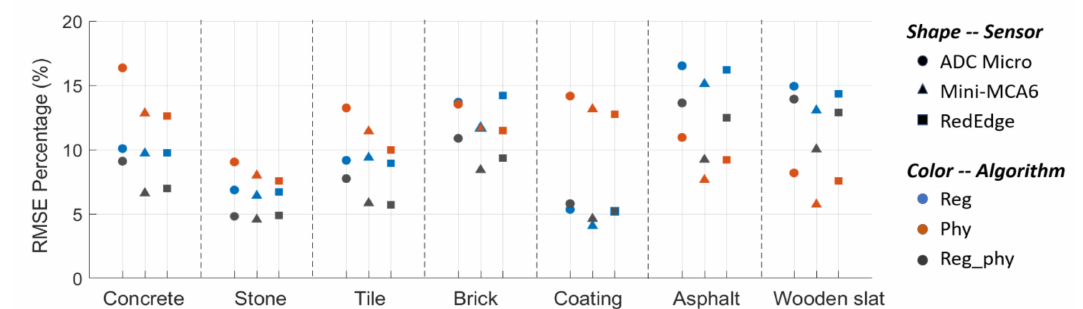
Figure 7. RMSE percentages of the three model-based estimated albedos with respect to the surface material